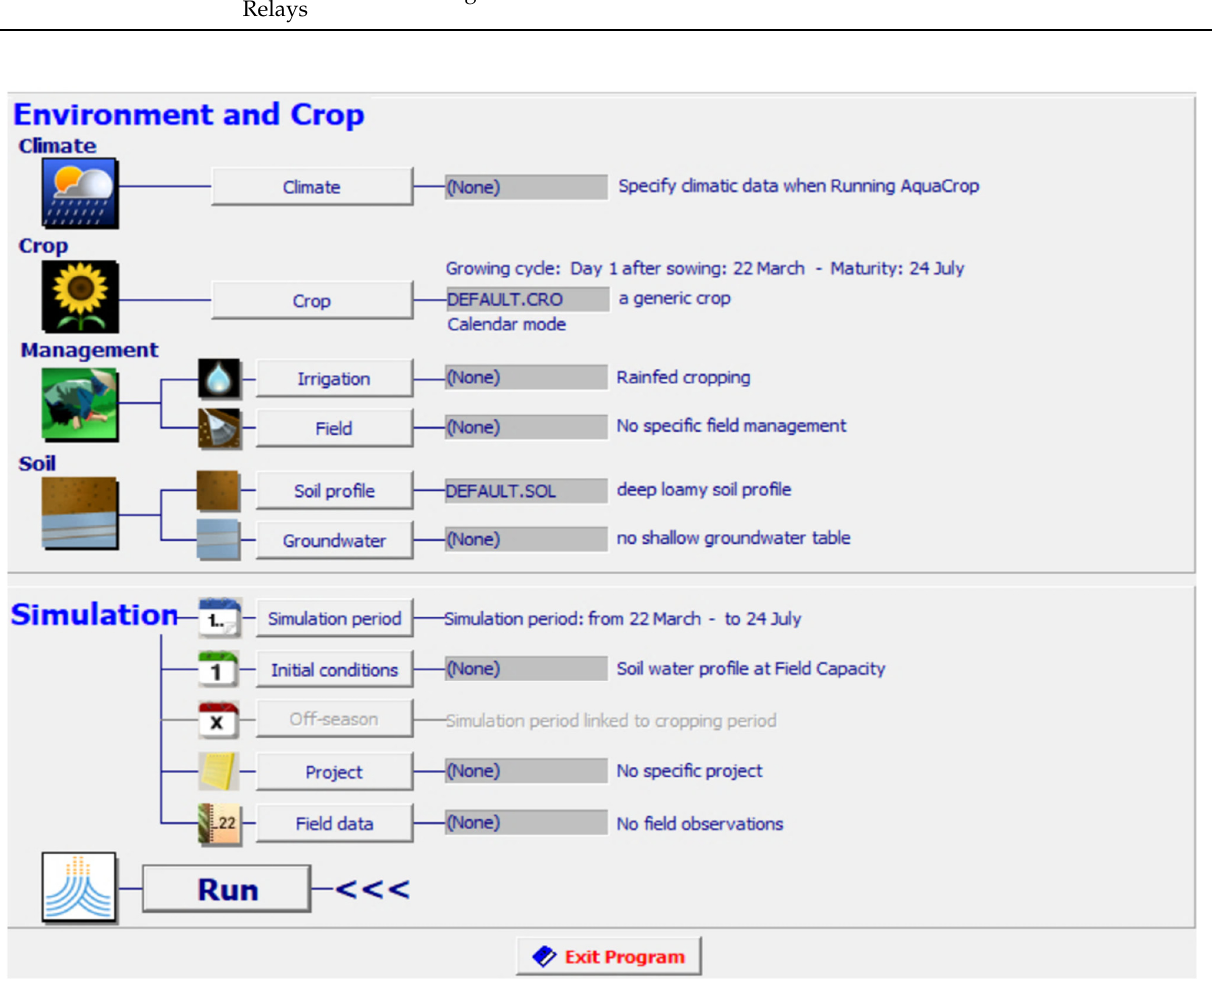
Figure 4. Screen shot of input parameters for simulation in AquaCrop.